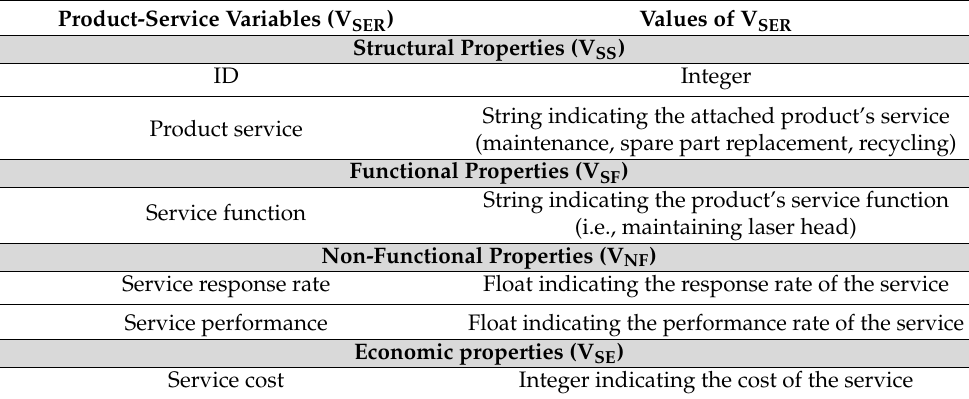
Table 6. Examples of product-service variables.